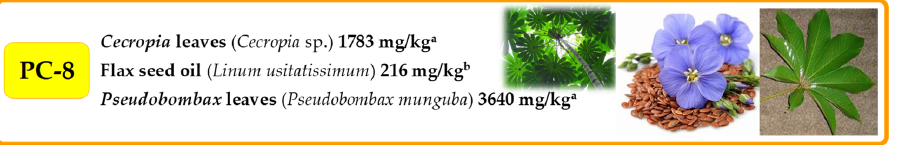
Figure 7. Selected richest sources of plastochromanol-8 (PC-8). Superscripts ( a–b ) refers to the fol- lowing literature positions: a , [65]; b ,